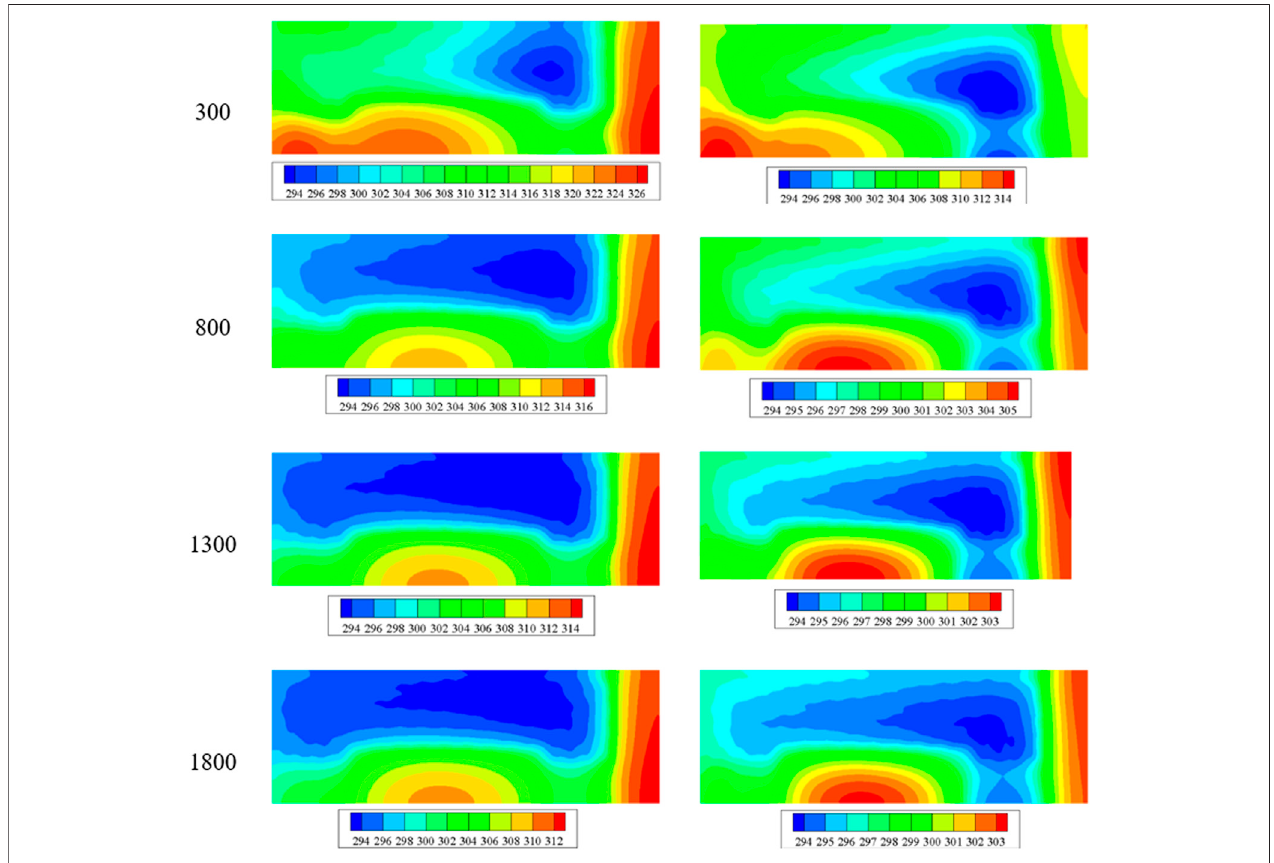
FIGURE 3 | Temperature contour of the H-S in for H 2 O and NF 2% in dissimilar Re.